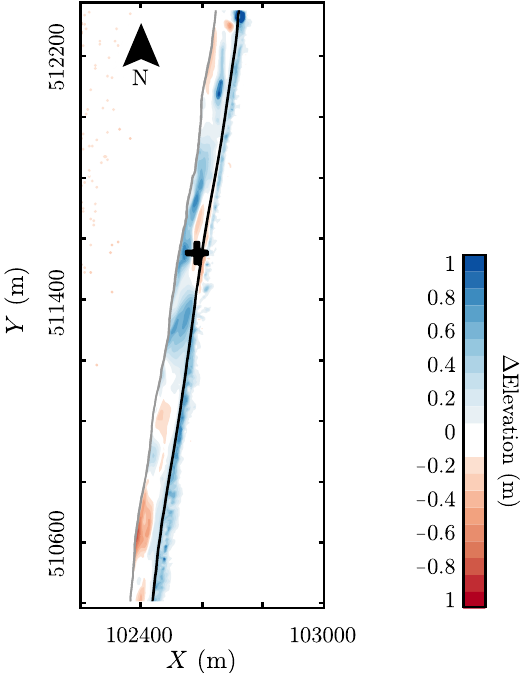
Figure 6. Change in elevation (m) at the beach and dunes area around the Coast 3D tower, between the years 2010 and 2009, obtained from the LiDAR data. The black line represents the contour line at 3 m+NAP and the gray line is the contour for 0 m+NAP. The location of the Argus Tower is represented by a black